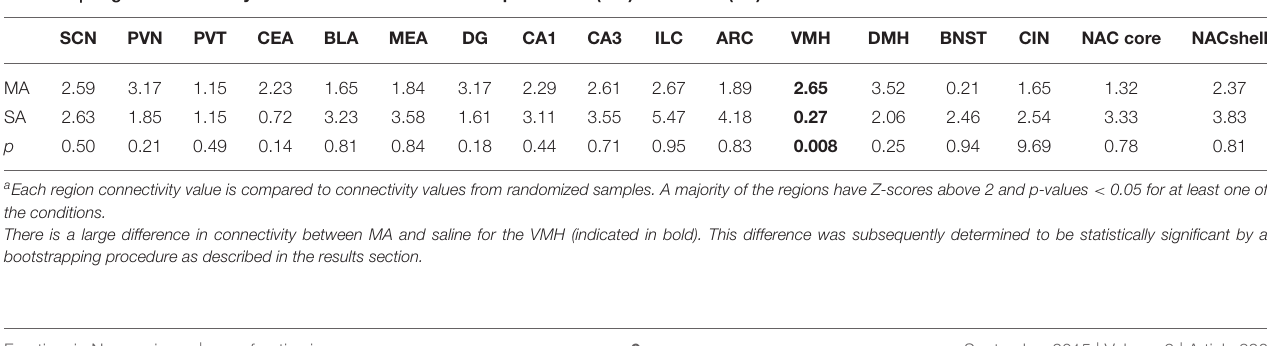
Frontiers in Neuroscience |